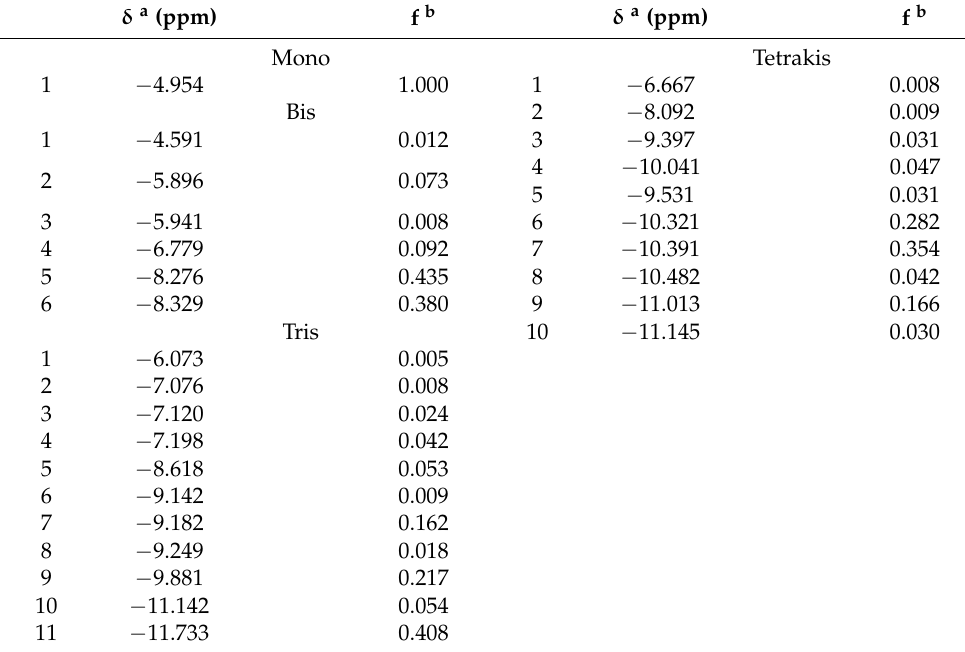
Table 1. Chemical shifts of addition products of C 60 and